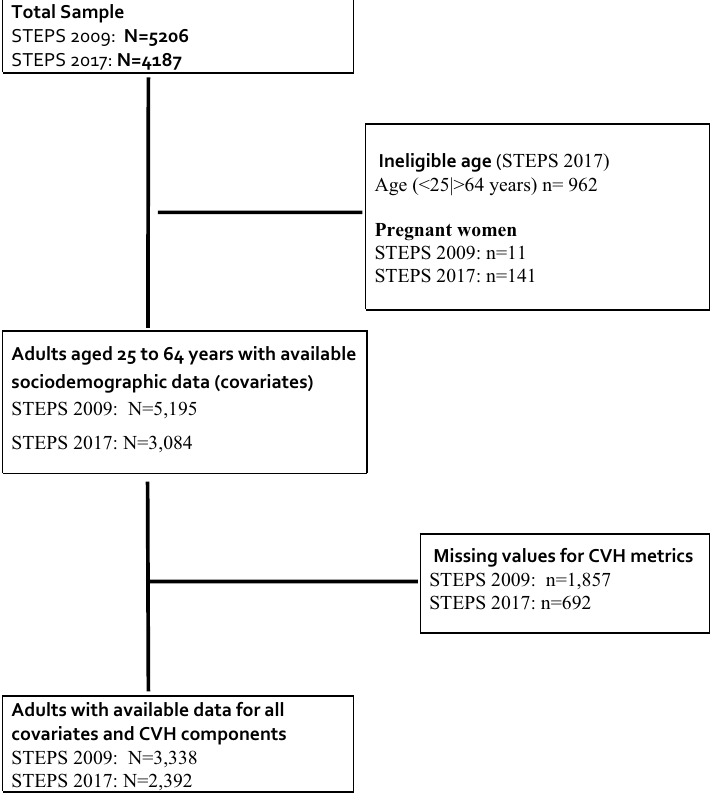
Figure 1. Population flowchart of participants 25–64 years in the 2009 and 2017 STEPS surveys in